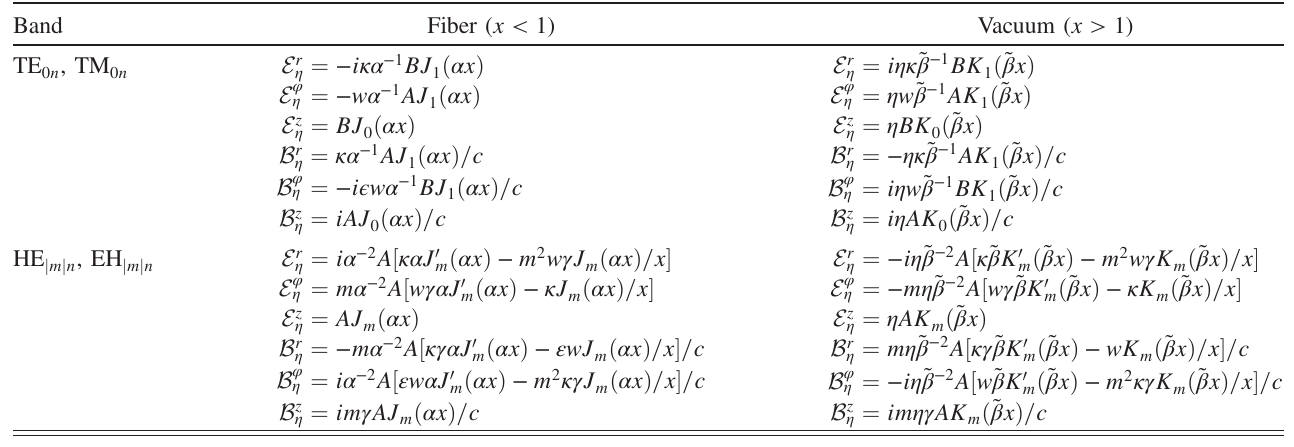
TABLE VI. Guided modes: Radial partial waves of the modal fields Eq. (A9) both inside the fiber and in the vacuum surrounding the modes are characterized by A ¼ 0 , and the TM 0 fiber. The quantities A , B ∈ C are amplitudes. The TE 0 n and EH modes have the same modal fields but distinct frequencies; see Table VII. The remaining amplitude is determined from the j m j n normalization condition Eq. (A13). All other quantities are defined in Table III.